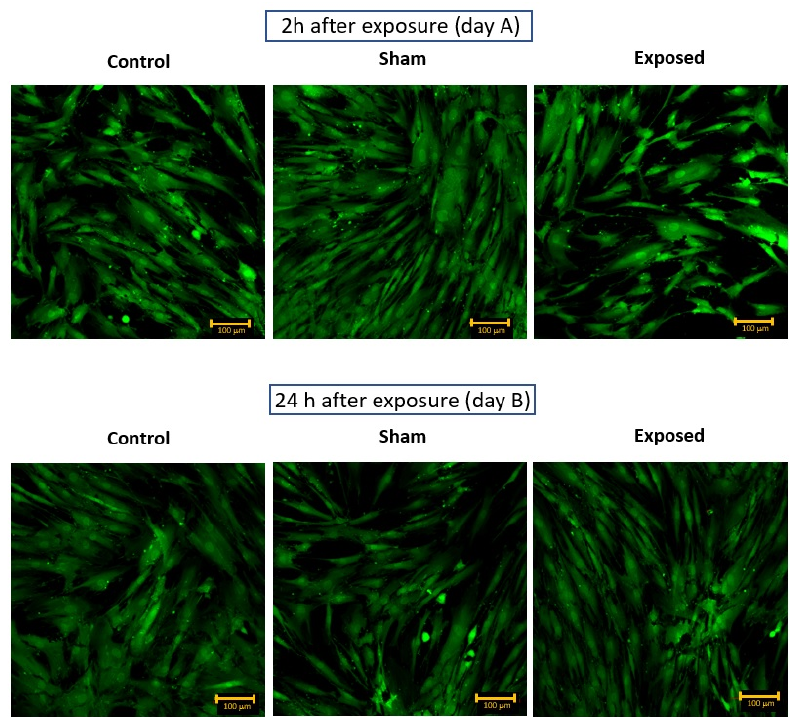
Figure 1. The viability of hMSC. Experiment no. 1: day A—2 h after exposure to EMP and day B—24 h after exposure to